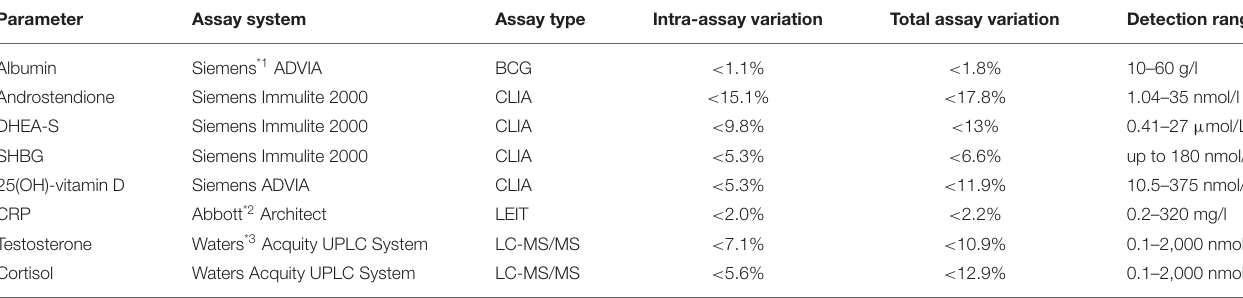
TABLE 1 | Assays and their performance